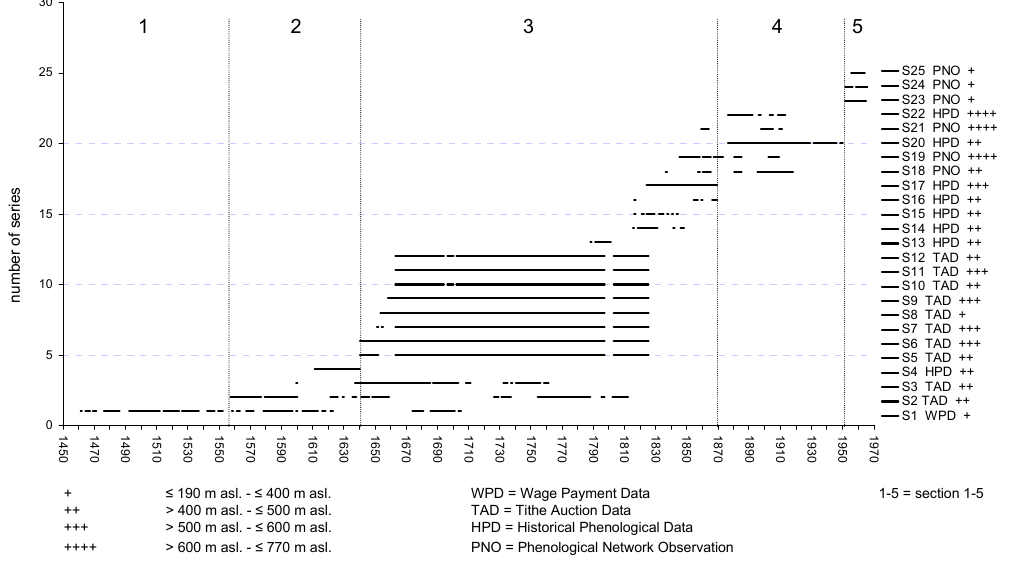
Fig. 3. Composition of Basel WGHD series; consisting of WPD-, TAD-, HPD- and PNO series from northern Switzerland and south western Germany.